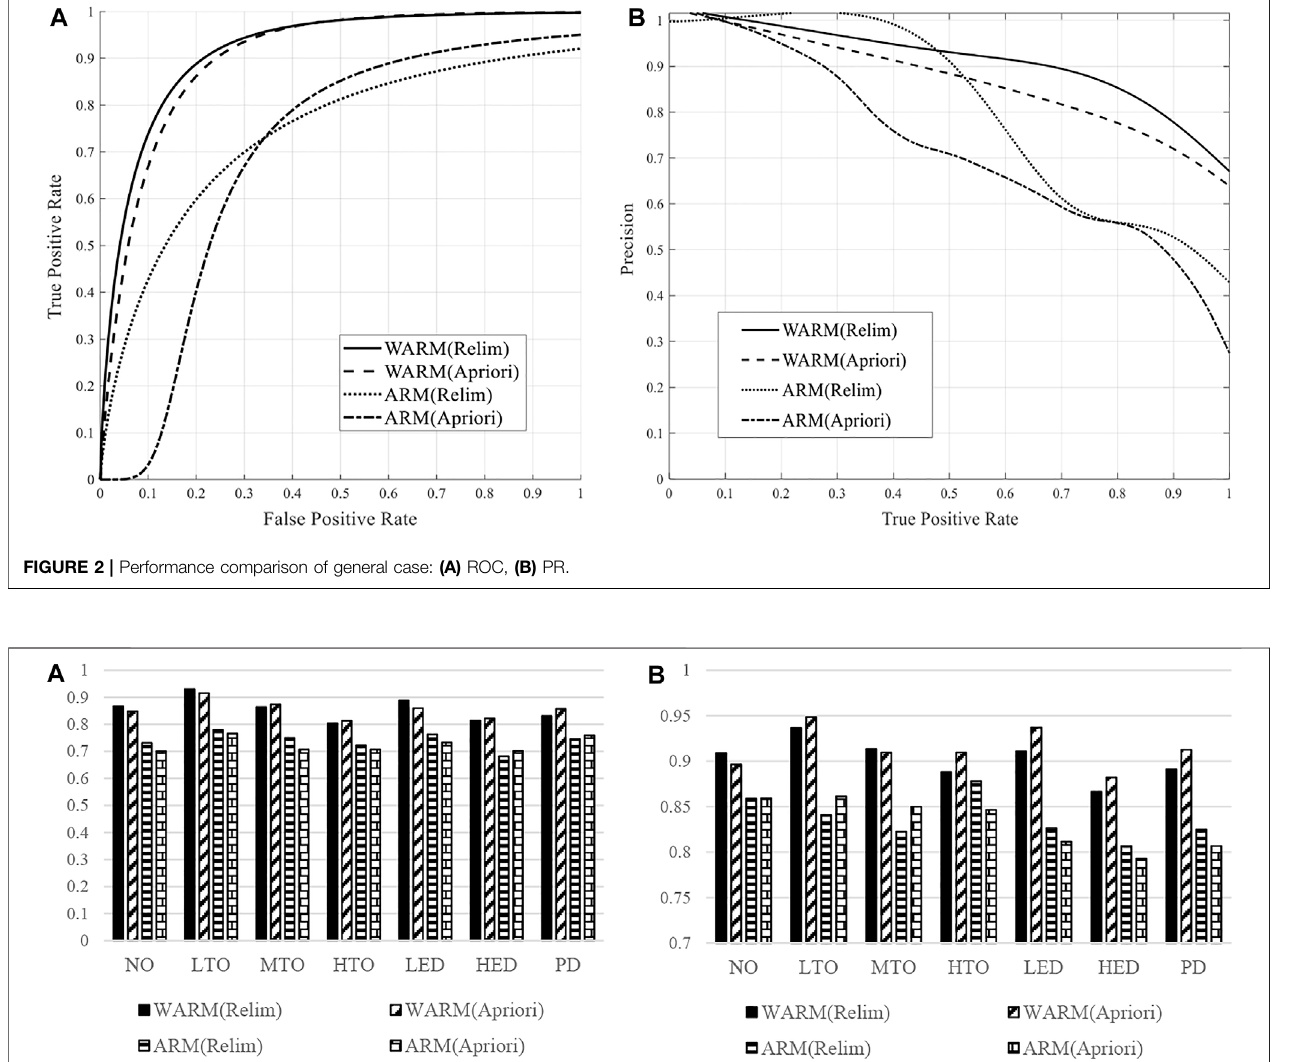
From Figure 3 , the enhancements in diagnoses